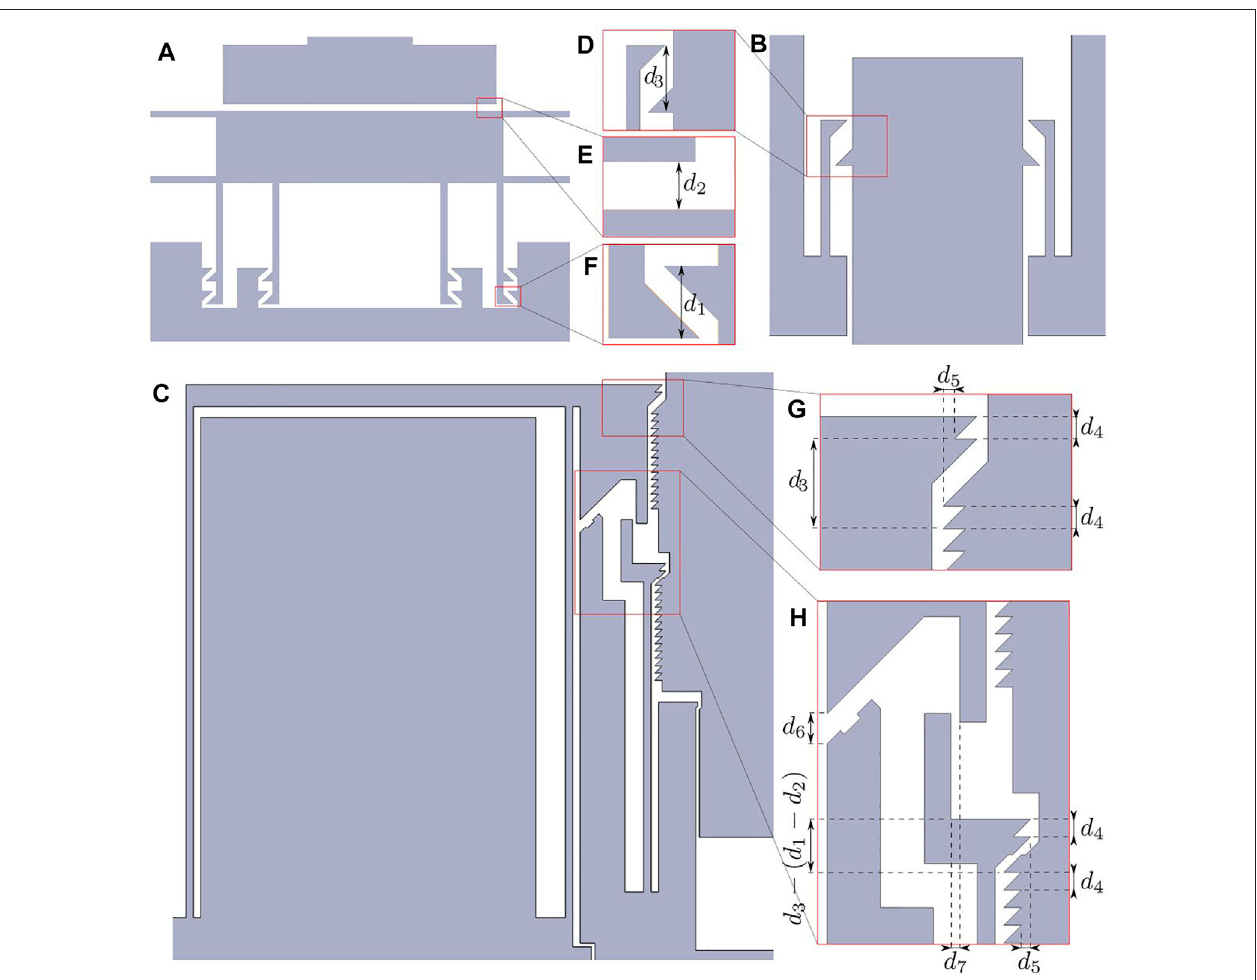
FIGURE 3 | As-fabricated con fi guration in the (A) bottom stop-block area, (B) top stop-block area, and (C) on the left side of the gripping area. Magni fi ed view of the distances between (D) teeth at the top stop-block, (E) bottom stop-block and shuttle, (F) teeth at the bottom stop-block, (G) teeth at the top gripper, and (H) interaction area between the gripper jaws and